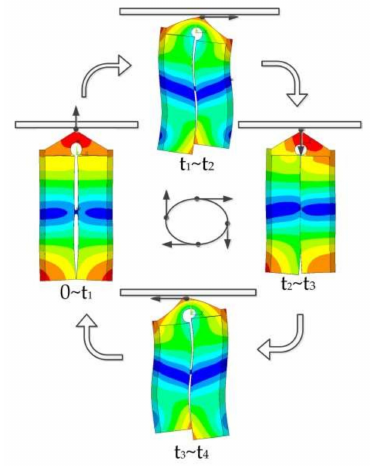
Figure 5. Stator actuation cycle.